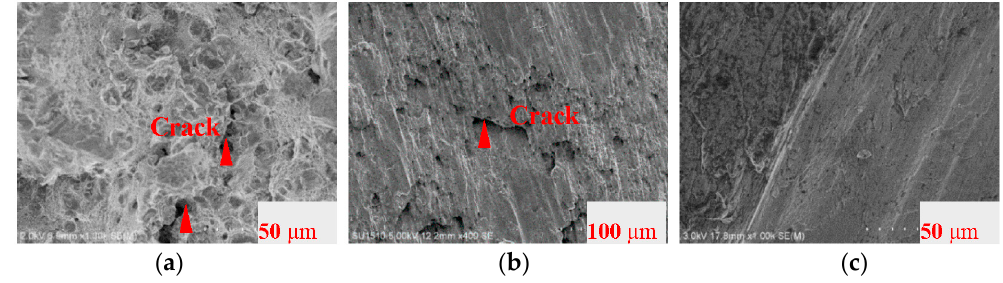
Figure 7. SEM images of the fracture sections under shear. ( a ) AL6061; ( b ) SS316; ( c ) LYS160.